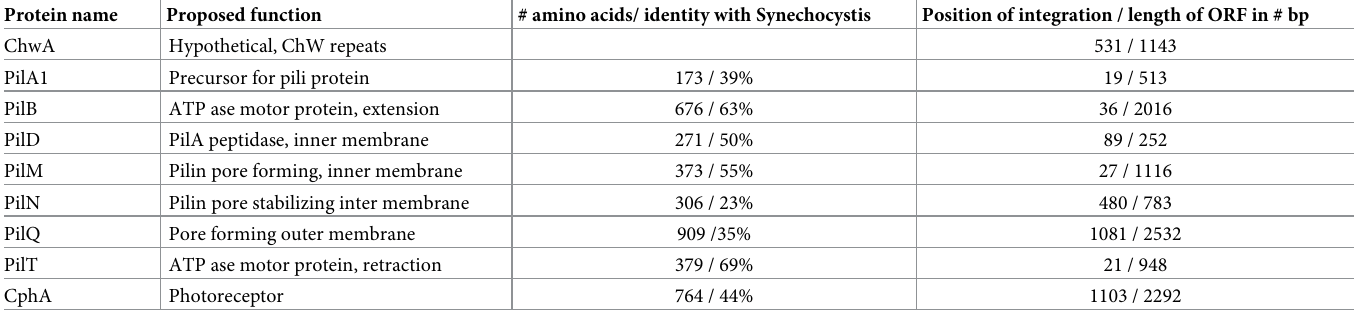
Table 1. Phormidium lacuna proteins and genes addressed in the present study. In the third column, the lengths of the protein sequences and the identities with Syne- chocystis sp. PCC 6803 protein homologs [55] are given. The fourth column gives the (proposed) position of the insertion of the KanR resistance cassette and the length of the entire open reading frame (ORF) in the number of base